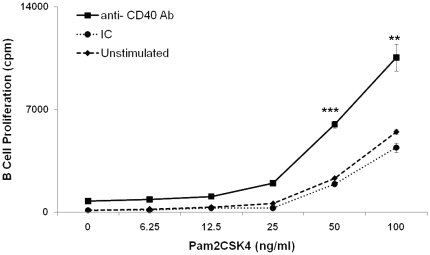
CD40 costimulation augments the proliferation of TLR-2 stimulated RB cells.RB cells were stimulated with anti-CD40 Ab and Pam2CSK4 (TLR2.CD40) and cultured for 16 h. 3H thymidine (0.5 µCi/well) was added and proliferation was checked after 16 h by liquid scintillation counting. Data indicate counts per min (cpm) and expressed as mean ± SEM of triplicate wells. Results are representative of four independent experiments. ‘*’, ‘**’, ‘***’ indicates p<0.05, p<0.01, p<0.001 respectively.